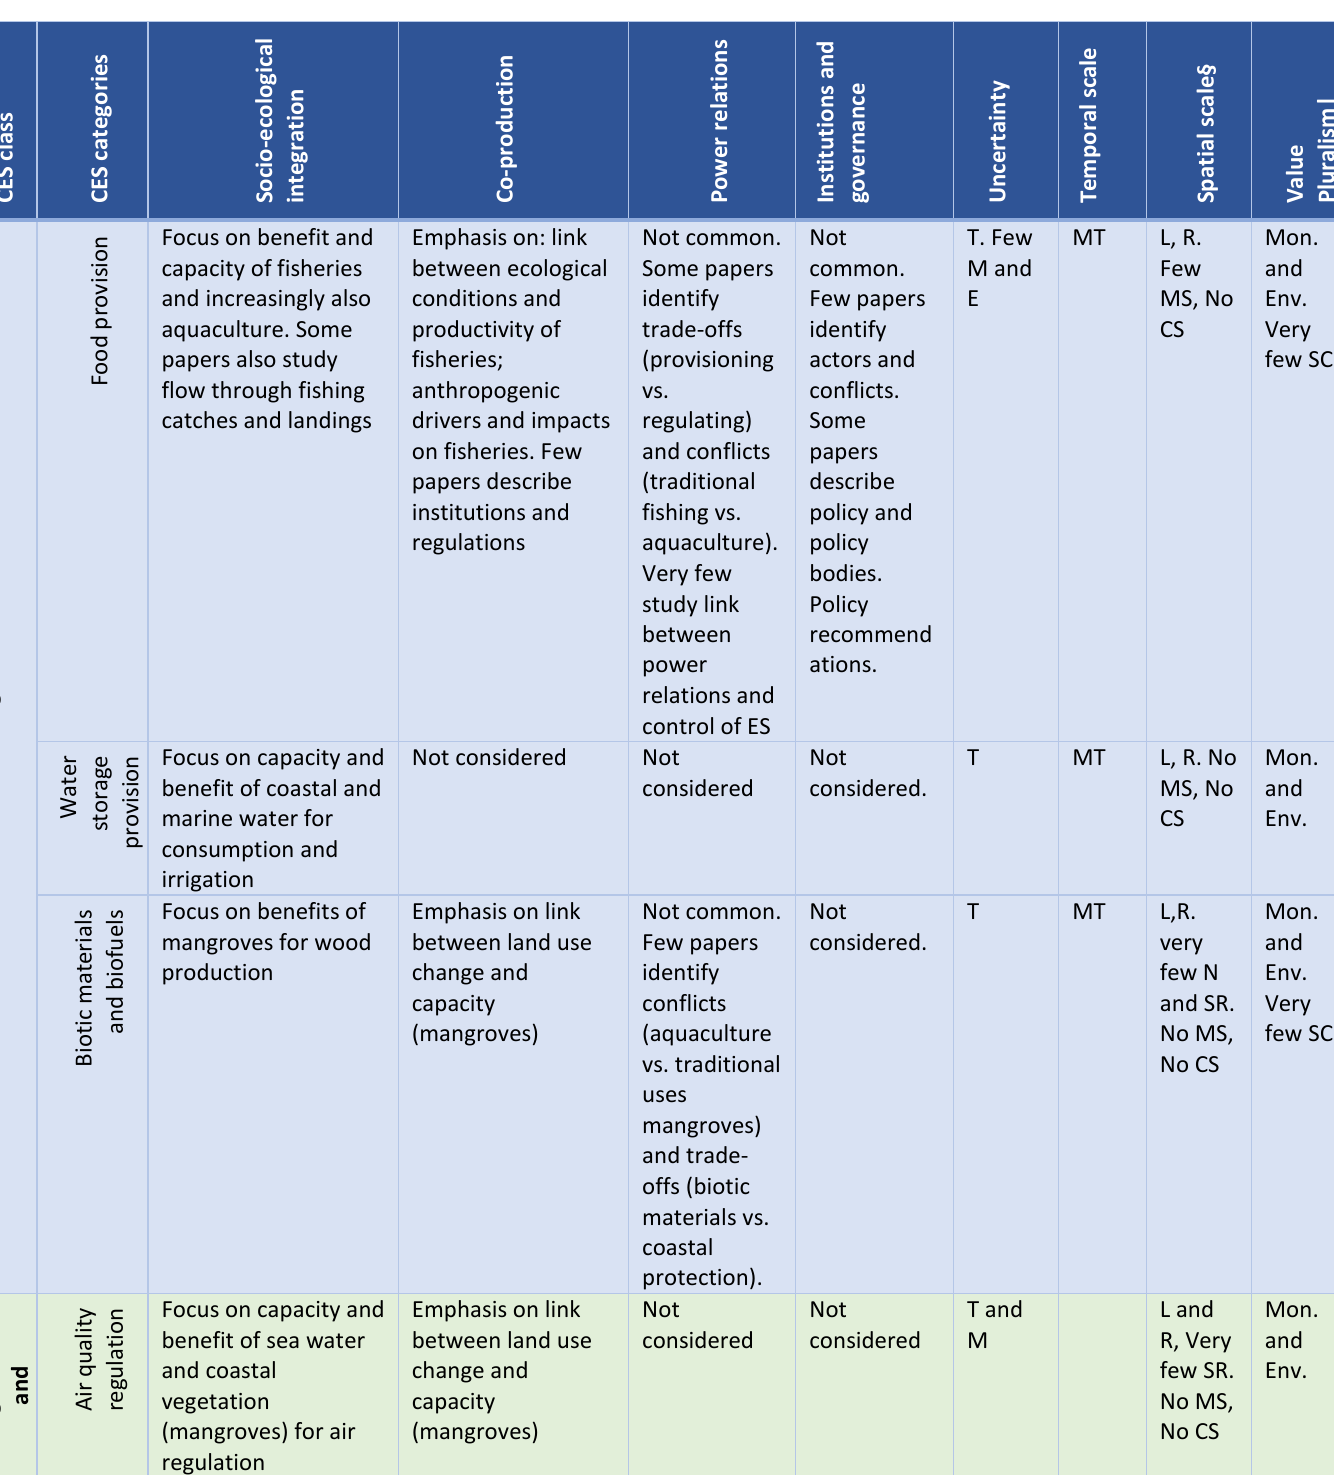
Table A1.1. Complete summary of the results of the literature